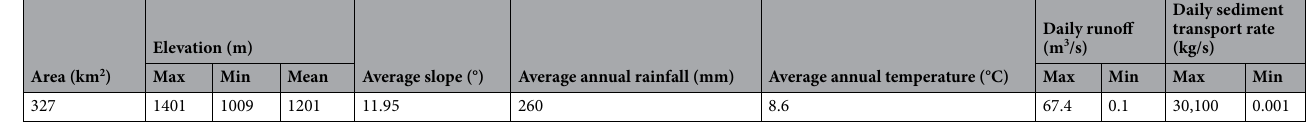
Table 1. Characteristics of the study catchment.